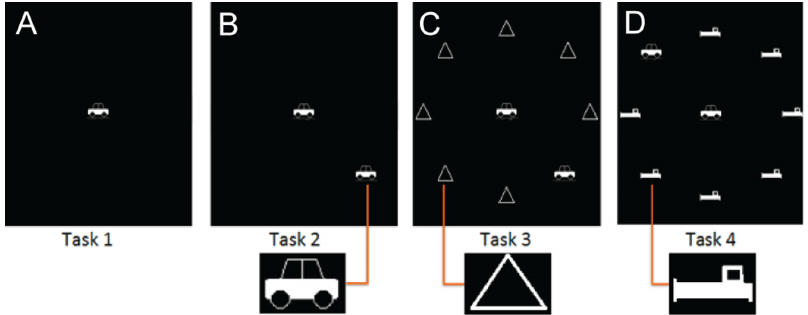
Figure 1. Task. The Useful Field of View-like task consists of 4 task levels. (A) Task 1 presents a central stimulus as car or truck for fixation. (B) Task 2 includes a car (6 u eccentricity) peripheral stimulus in one of eight spots near the edge of the screen. Task 3 and 4 are identical to task 2 aside from additional (C) triangle distractors in task 3 and (D) car-like distractors in task 4. Participants respond by clicking on a picture of the central stimulus and a box representing the location of the peripheral